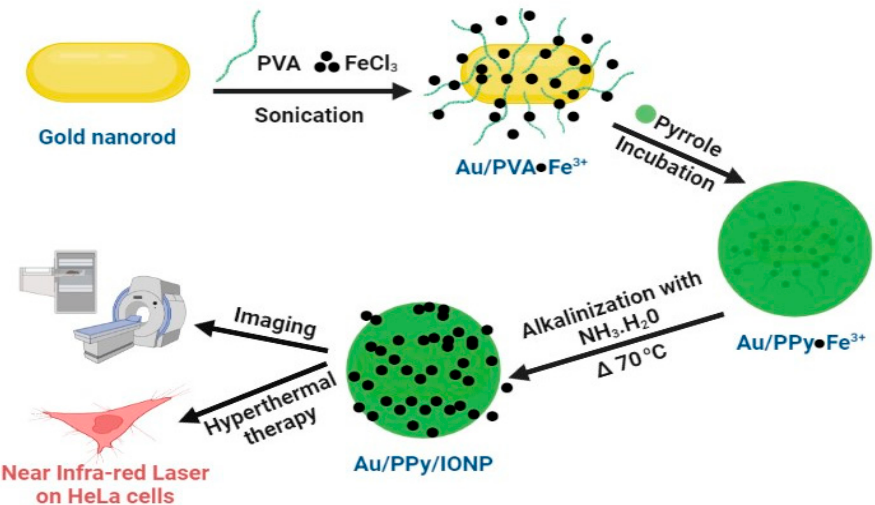
Figure 2. Synthesizing scheme for mGNP using polypyrrole as intermediate layer.